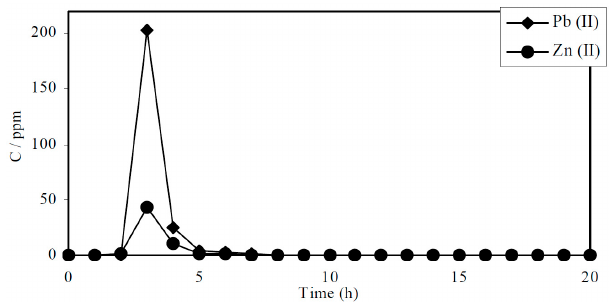
Figure 4. Pb(II) and Zn(II) elution profiles when the loaded crosslinked lignocatechol column was eluted with 1 M hydrochloric acid. Flow rate = 3.00 mL/h [6]. (With permission for reuse from Elsevier B.V.).